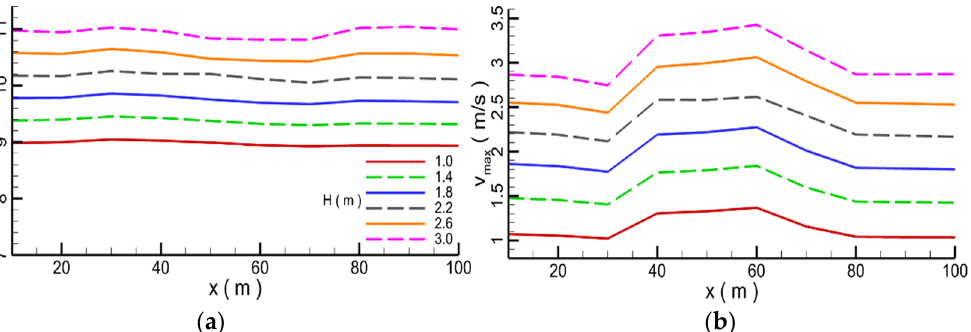
Figure 22. The maximum water level and velocity recorded with different wave heights; ( a ) water level; ( b ) velocity.